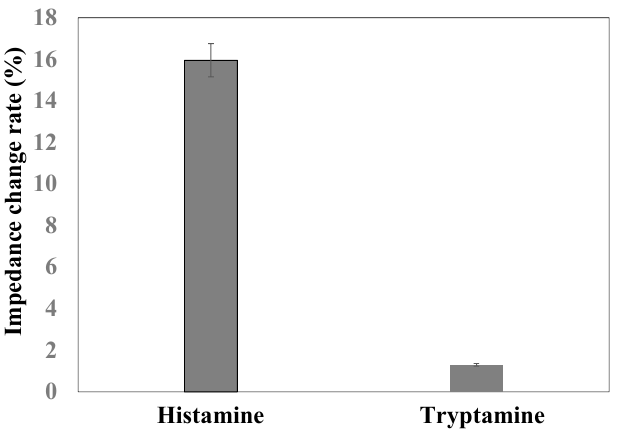
Figure 7. Comparison of impedance change rate of tryptamine and histamine detection.